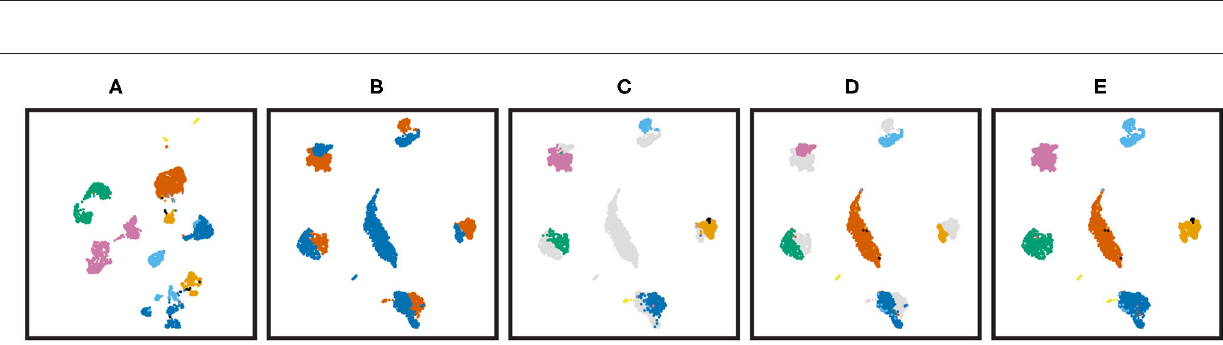
FIGURE 5 | Two violin plots of (A) alpha cells and (B) beta cells in Batch 1 showing the expression of the top 30 differential expressed genes between two sub groups within either the alpha cells and beta cells. Cells within the two sub groups are colored differently and shown on the left of plots.